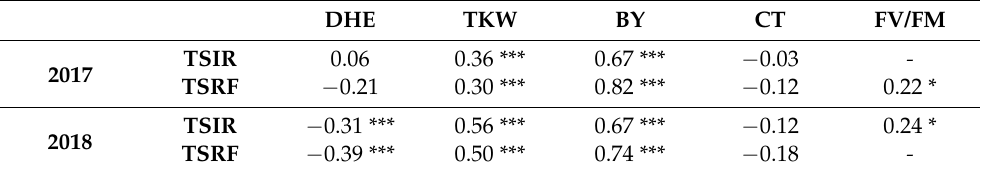
Table 6. Pearson correlation coefficients of grain yield (GY) to days to heading (DHE), thousand kernel weight (TKW), total biomass (BY), canopy temperature (CT), and Fv/Fm at Tessaout under irrigated (TSIR) and rainfed (TSRF) conditions during two consecutive seasons of 2016–2017 and